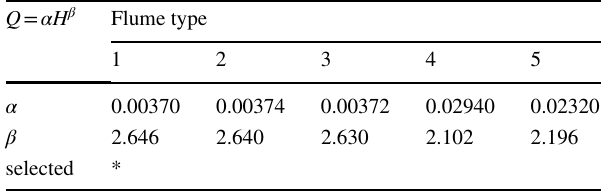
Table 1 Calibration coefficients of short-trapezoidal throat flume ( H flow height)